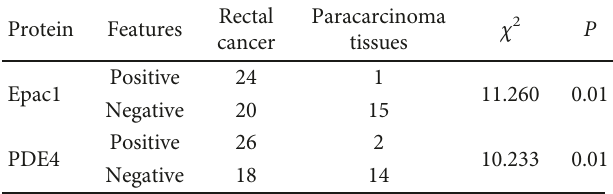
Table 1: PDE4 and Epac1 protein levels in rectal cancer tissues.